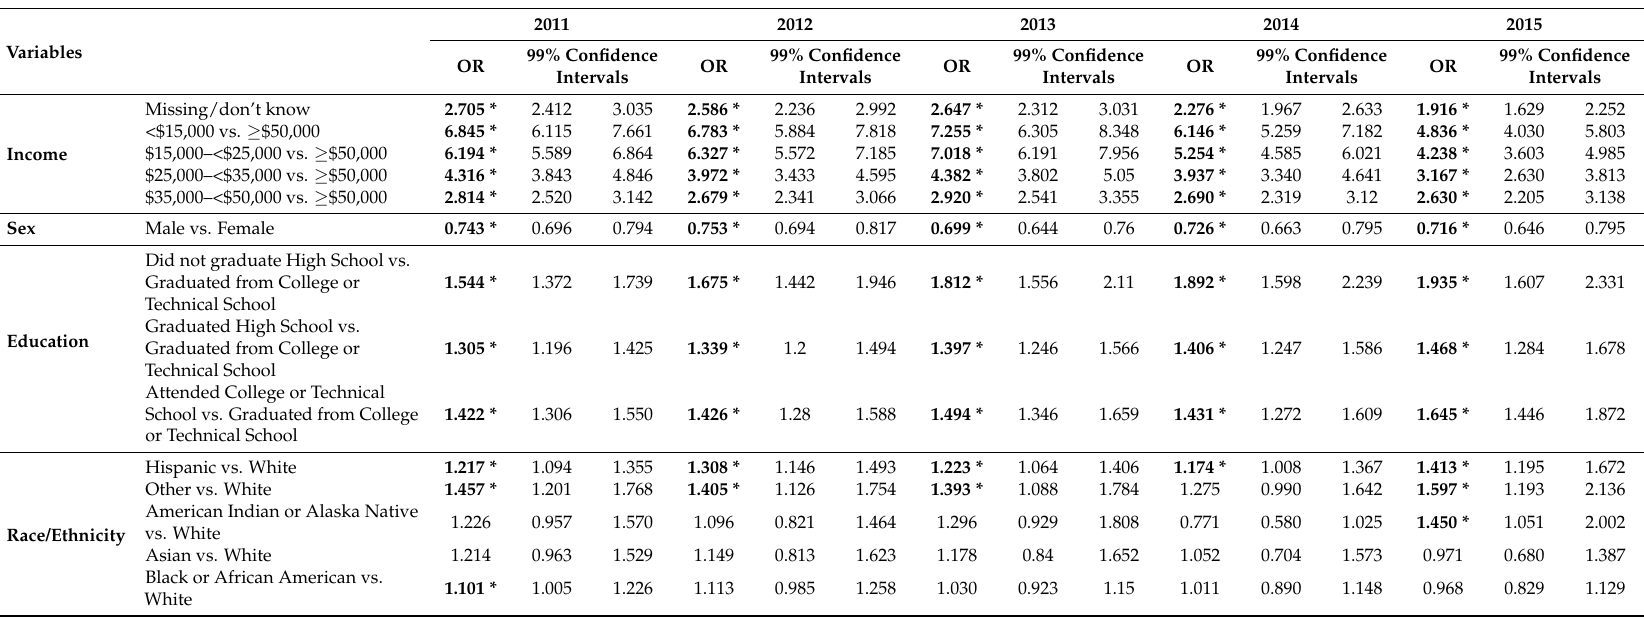
Table 3. Adjusted Analysis for Forgone Care among individuals aged 19–64 years of